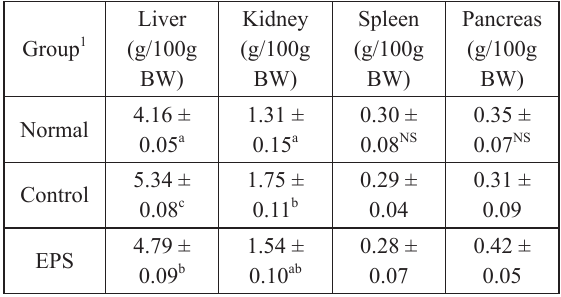
Effect of P. geesteranus 5 # EPS on the various organs in streptozotocin-induced diabetic mice for 3